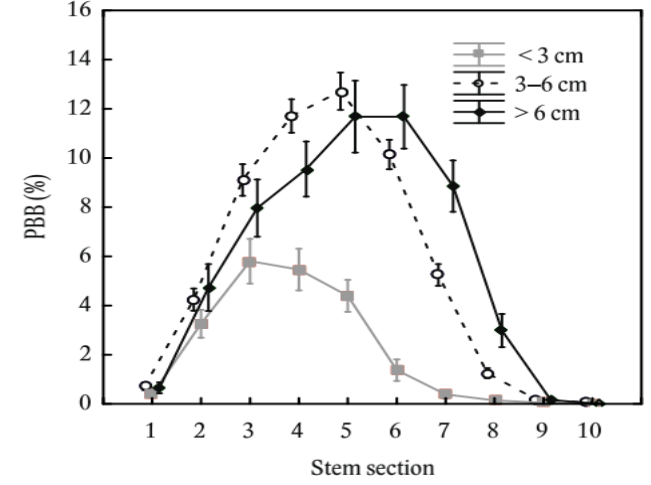
Figure 5. Stem bark browsing on common aspen ( Populus tremula L.), common rowan ( Sorbus aucuparia L.), and goat willow ( Salix caprea L.) together considering stem sections and diameter classes of stems. The stem browsing is expressed on a relative basis (i.e., proportion of browsed bark mass to full bark mass potential). The error bars indicate standard errors. The stem sections are coded as 1: 0–25 cm, 2: 26–50 cm, 3: 51–75 cm, 4: 76–100 cm, 5: 101–125 cm, 6: 126–150 cm, 7: 151–175 cm, 8: 176–200 cm, 9: 2: 201–225 cm, and 10: 226–250 cm from the ground level.